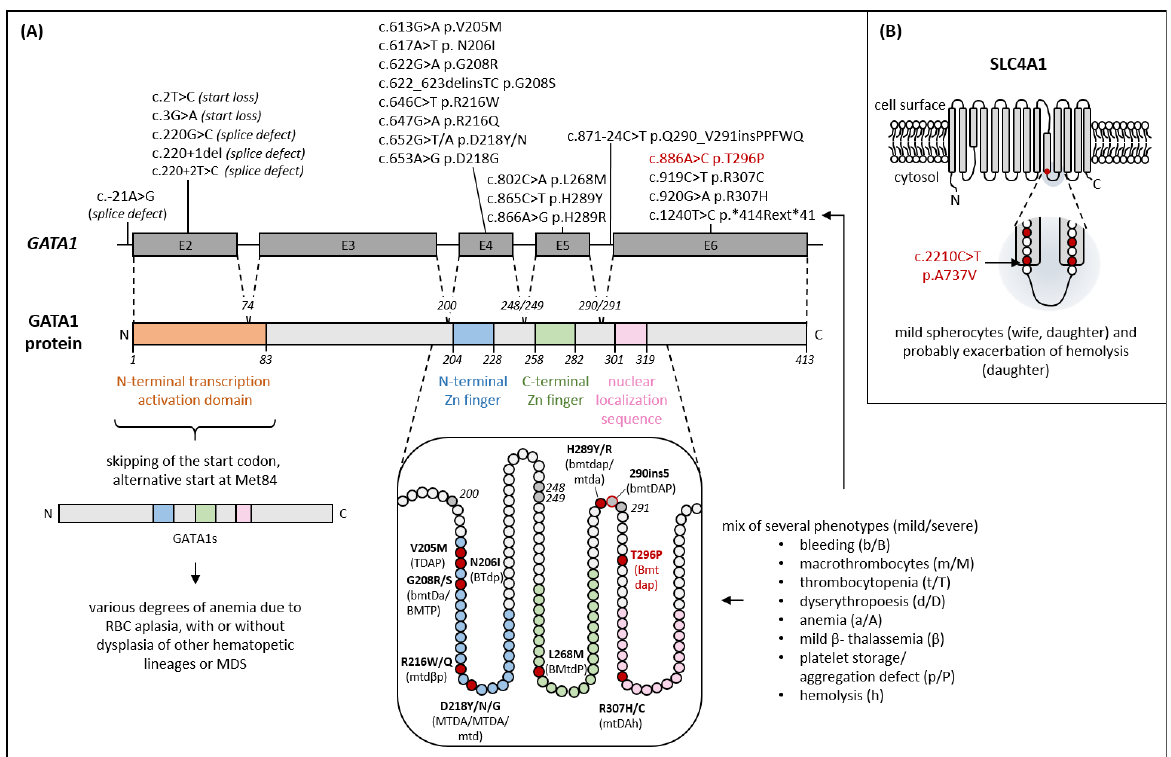
Figure 6. ( A ) Schematic representation of germline GATA1 variants (NM_002049.4) with available functional analyses. The newly identified variant c.886A>C p.T296P is highlighted in red. Variants upstream and in exon 2 led to a skip of the actual start codon and used Met84 as a new start codon, resulting in a truncated GATA1, the GATA1s. All other variants cause different phenotypes, which are described by the letters in brackets in the enlarged representation of the region. [28,29,42,45–49] The letters correspond to the phenotypes listed next to it and the severity is symbolized by upper or lower case (lower case = mild, upper case = severe). In the enlarged view, the amino acids are shown as circles (red fill or border = mutated; gray fill = exon border). The illustration is merely schematic and does not represent secondary structures. ( B ) Transmembrane helices of SLC4A1 (NM_000342.4). The newly discovered variant A737V is located at the end of the 10th transmembrane helix of SLC4A1, and other variants known to cause hereditary spherocytosis or stomatocytosis in the close vicinity are highlighted (red circles) [36] .